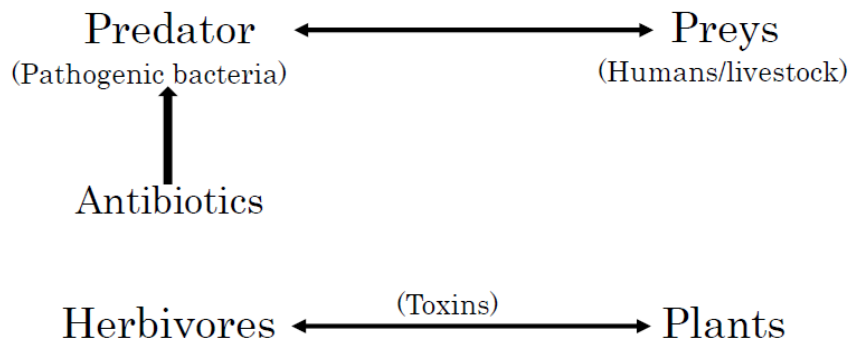
Figure 6. The relationship between predators and prey, and herbivores and plant.